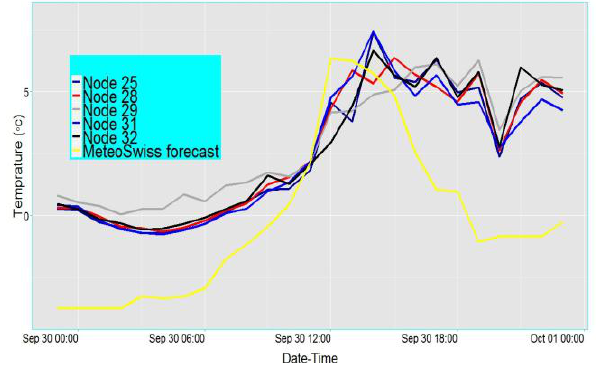
Figure 3. The patterns of WSN ambient temperature measurements and MeteoSwiss forecasts on 2007-09-30.